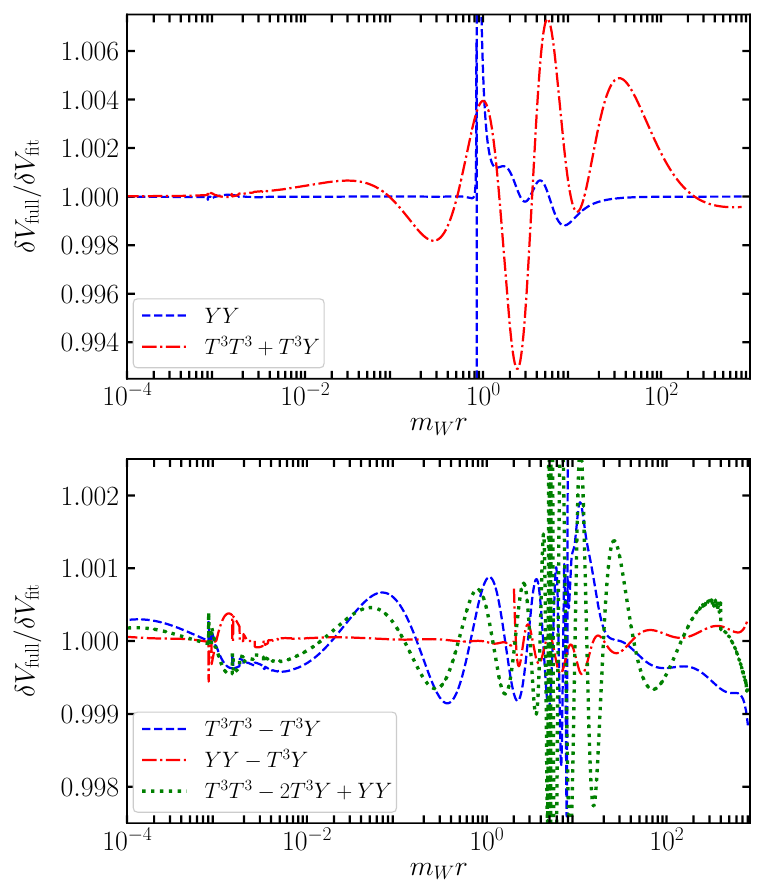
Figure 7 . Ratio of the numerical Fourier transform of the potential correction to the fitting functions in the variable x = m W r for the channels Y Y (blue/dashed) and T 3 T 3 + T 3 Y (red/dash-dotted) in the upper panel. In the lower panel, the same ratio is shown for the channels with power-like large distance asymptotic behaviours T 3 T 3 − T 3 Y (blue/dashed), Y Y − T 3 Y (red/dash-dotted) and T 3 T 3 − 2 T 3 Y + Y Y